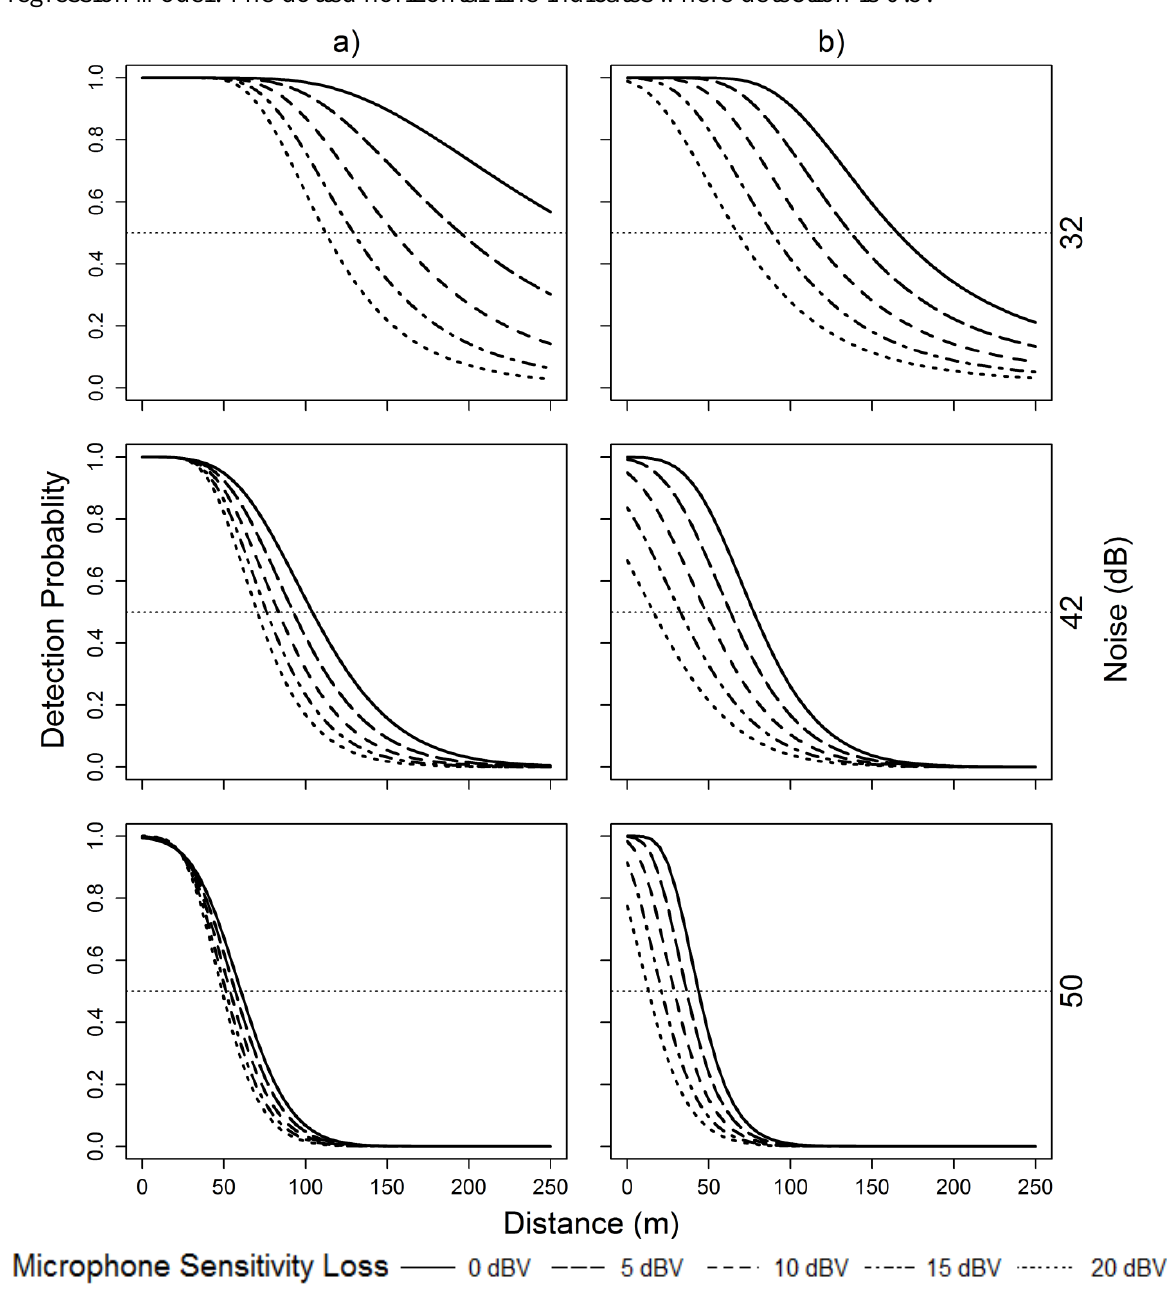
Figure A4.2. Detection probabilities of a) Nelson’s Sparrow and b) Sedge Wren for five levels of microphone sensitivity loss and under three noise conditions based on selected binomial regression model. The dotted horizontal line indicates where detection is